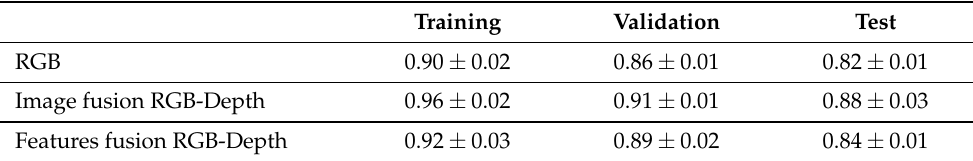
Table 4. Seedling growth stage classification average accuracy and standard deviation when per- formed over 10 repetitions of transformer